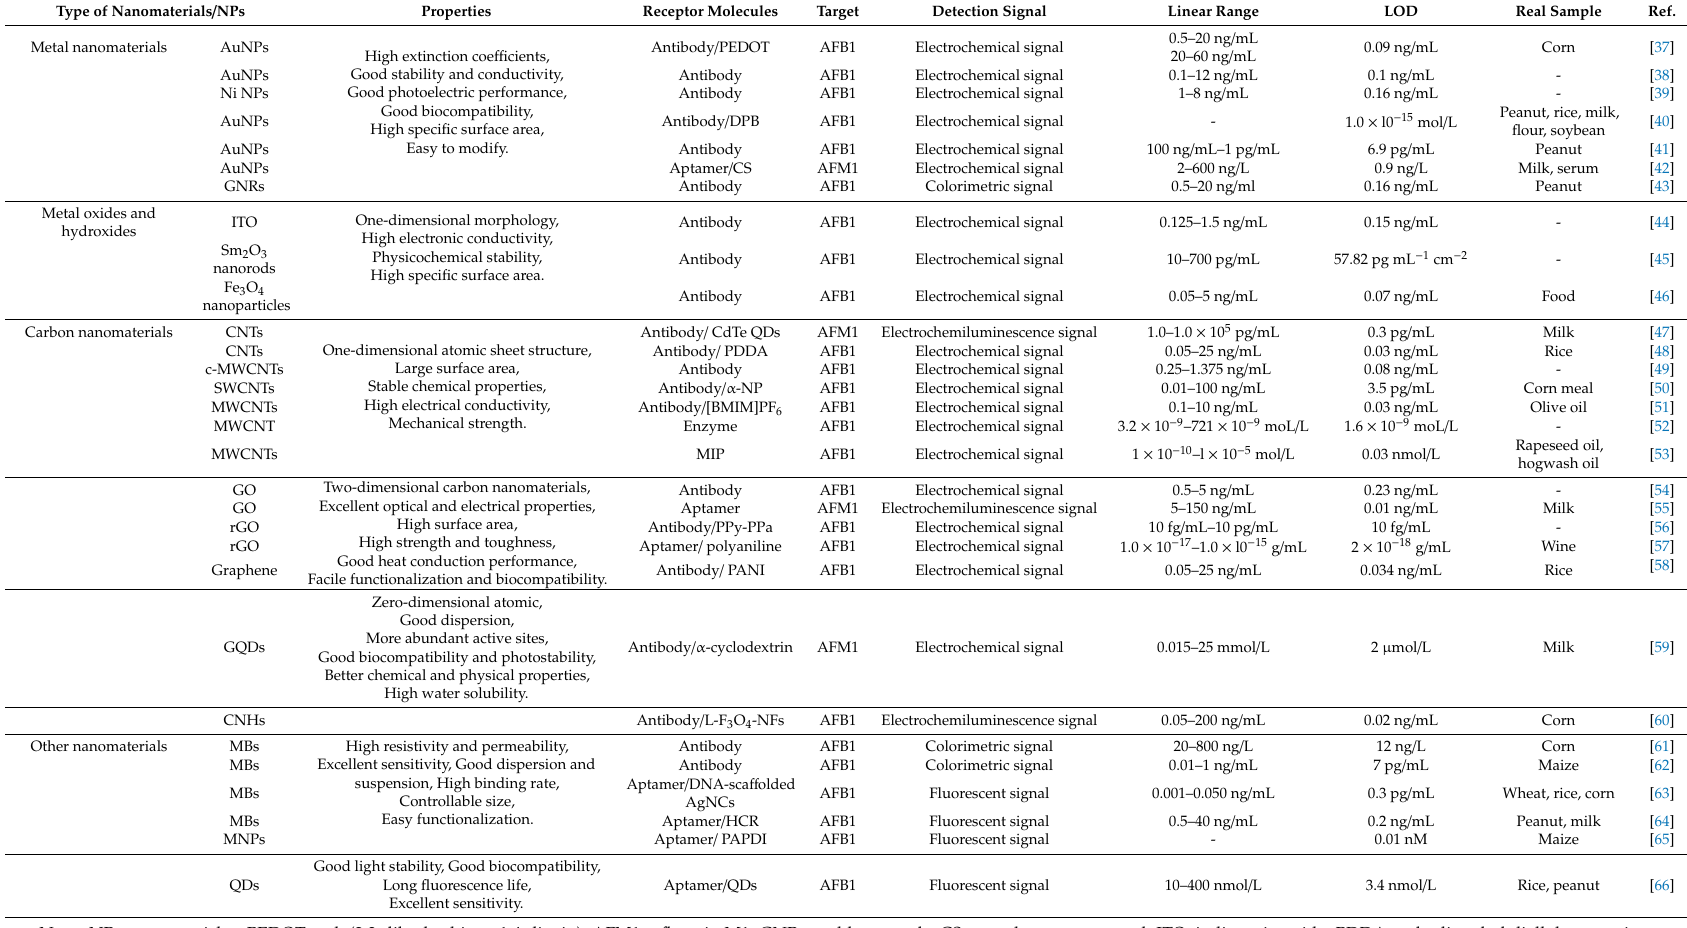
Table 2. Di ff erent nanomaterials used for aflatoxins